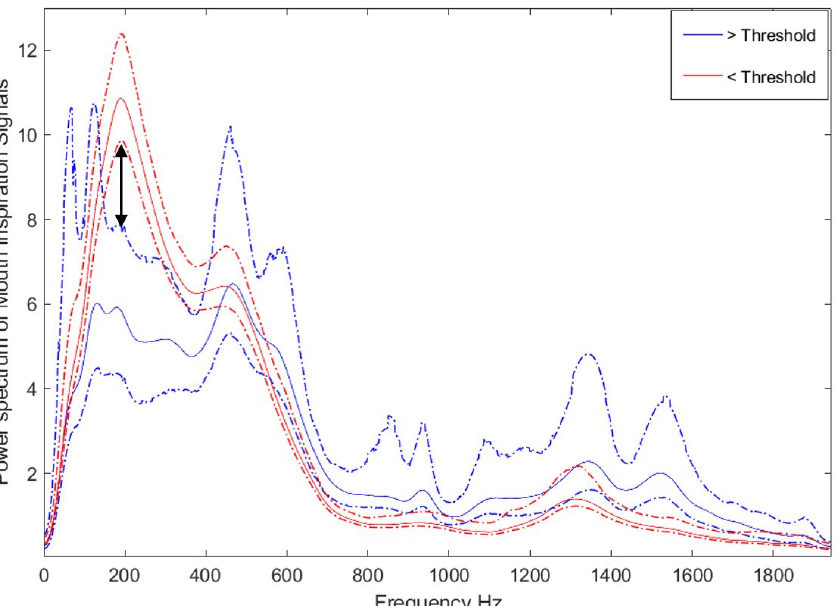
Figure 2. The average power spectrum of the signal recorded from mouth inspiration. Dotted lines represent the 95% confidence interval. Red and blue color curves represent the groups with more and less than a threshold, respectively. The arrow shows a large gap beyond the confidence interval between the two groups.